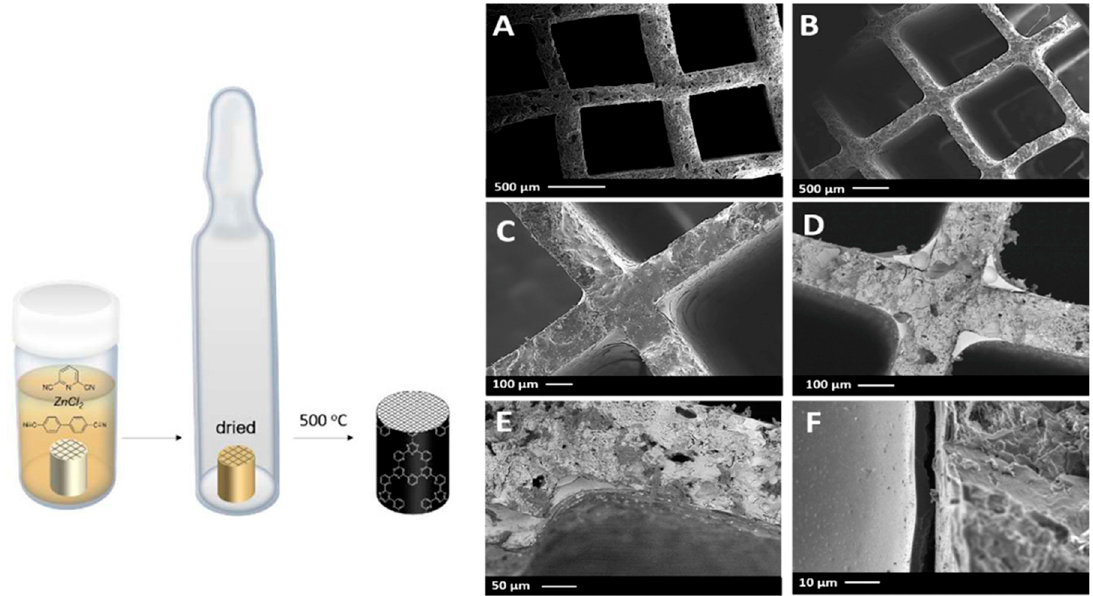
Figure 4. ( A ) SEM of a cut CTF-based sphere; ( B ) synthesis conditions for the shaping of CTF; ( C ) SEM